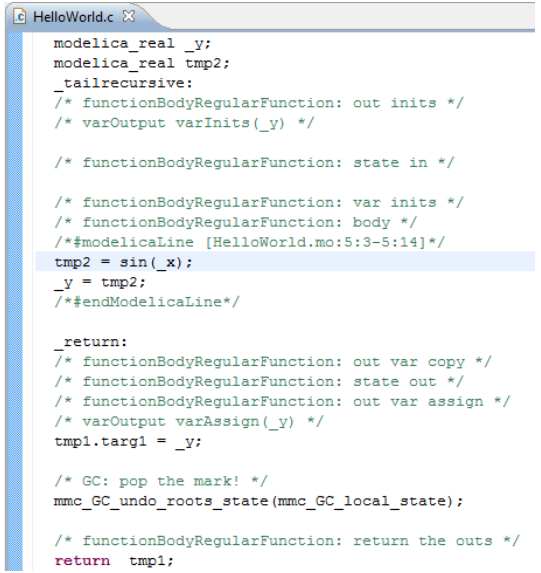
Figure 8: Generated C source-code.